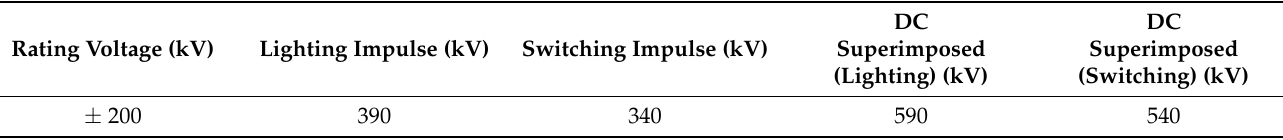
Figure 15. Final model considering the design factors. Table 7. Ratings of the final model.